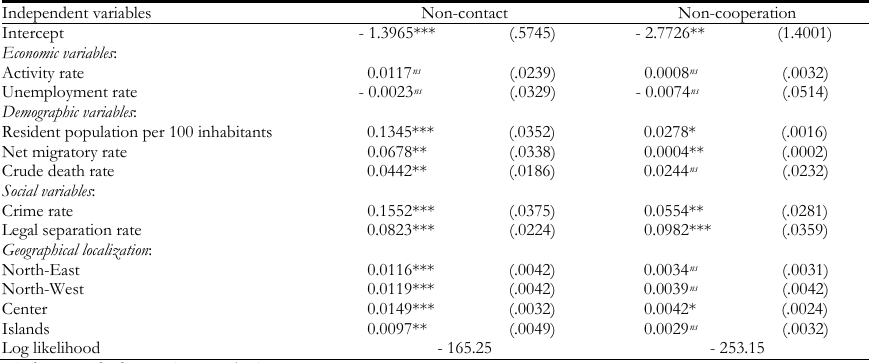
Multinomial logistic model: non-contact and non-cooperation vs participation – wave 2004 Independent